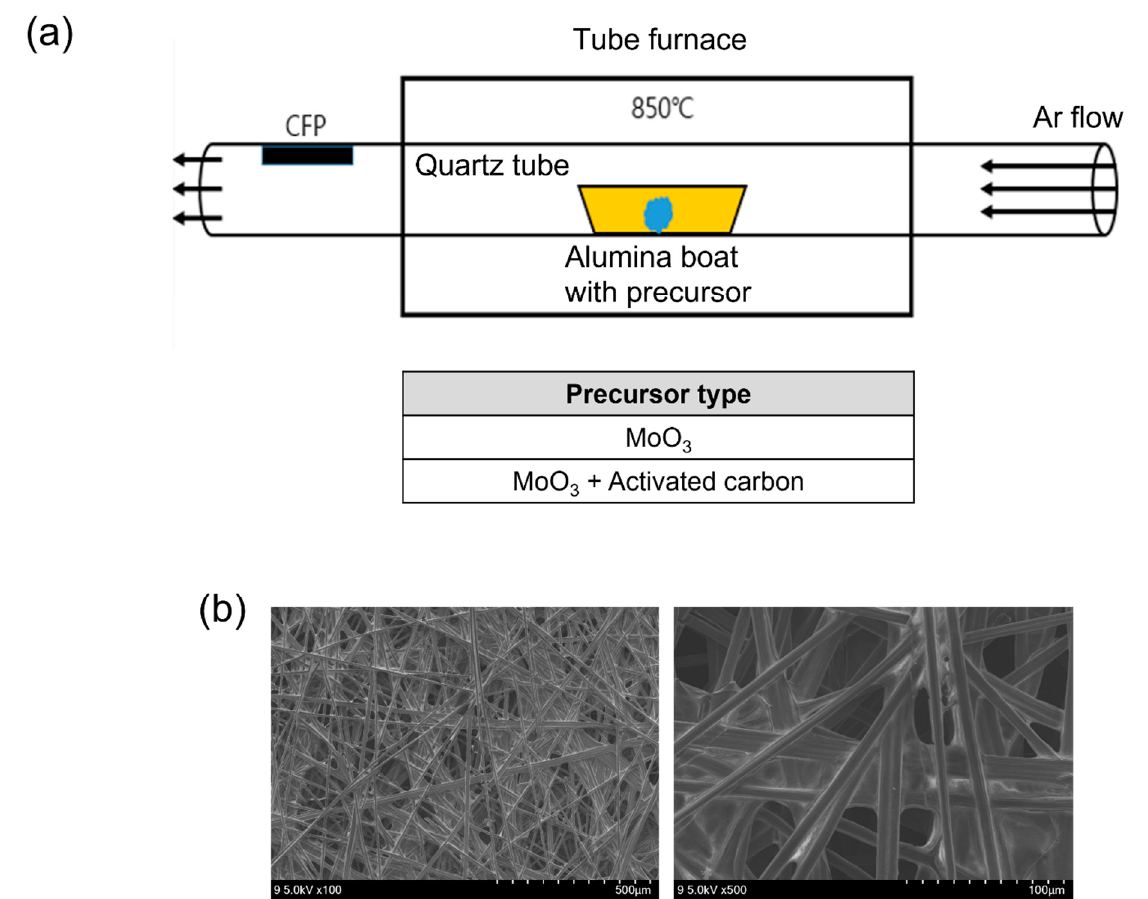
Figure 1. ( a ) Illustration of the chemical vapor transport (CVT) process combined with the quenching effect achieved by placing the position of the substrate outside the tube furnace, used to grow molybdenum oxide nanoparticle aggregates on carbon fiber paper (CFP) substrates using two different types of precursors. ( b ) FE-SEM images of bare CFP.